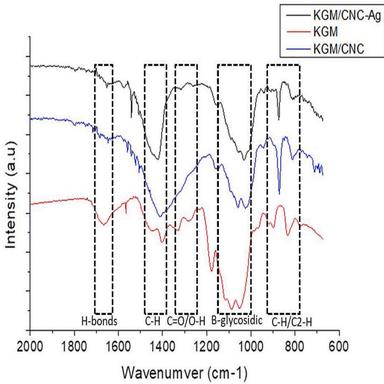
Infrared spectra for KGM, KGM/CNC and KGM/CNC-Ag asymmetric membranes.